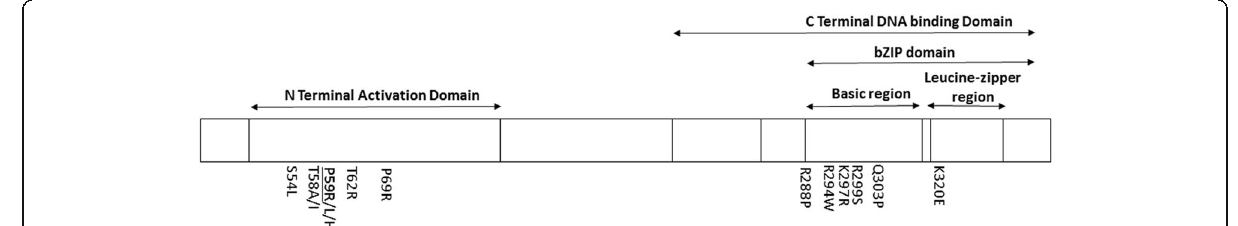
Fig. 3 Schematic of the human MAF protein indicating the positions of reported variants (Adapted from Niceta et al. [27]). The protein contains an N-terminal transactivation domain and a C-terminal DNA binding domain. The C-terminal domain consists of an extended homology region, basic region (aa288 – 313) and leucine-zipper region (aa316 – aa337). The variants associated with Aymé-Gripp syndrome are located in the N-terminal transactivation domain including the variant (p.(Pro59Arg)) reported here ( bolded and underlined ). Other variants are located within the C-terminal DNA-binding domain and are associated with other forms of congenital cataract mainly